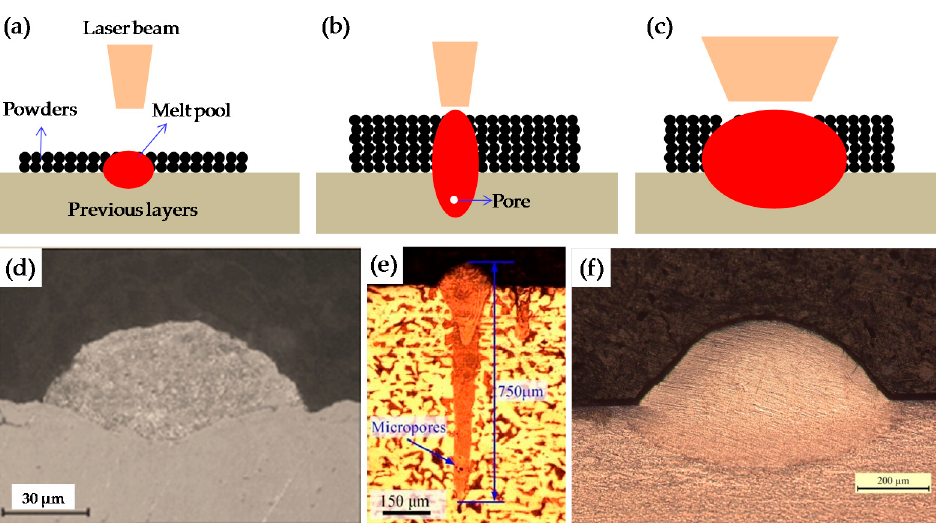
Figure 7. ( a – c ) Schematic sketches of the selective laser melting (SLM) process of different melt pools; ( a ) fabrication at a thin layer with a small-diameter laser; ( b ) fabrication at a thick layer with a small-diameter laser; ( c ) fabrication at a thick layer with a large-diameter laser; ( d – f ) OM micrographs of the cross section of single scan tracks at different layer thicknesses; ( d ) δ = 50 μ m [13]; ( e ) δ = 100 μ m [10]; ( f ) δ = 200 μ m.